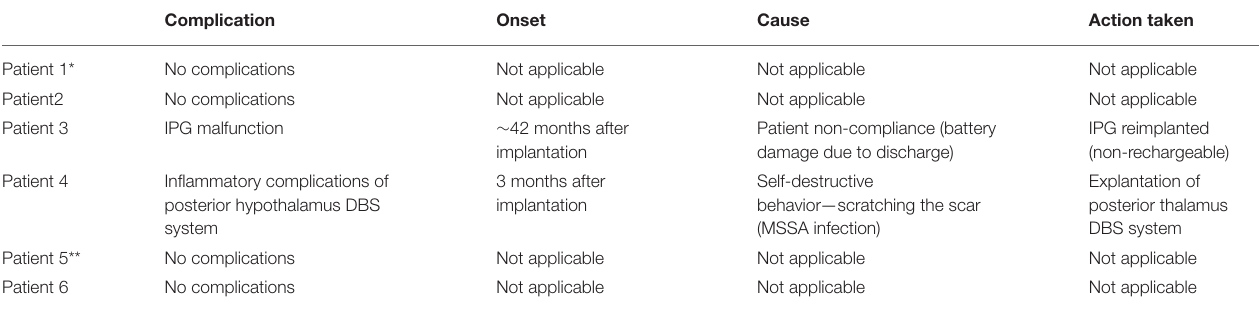
TABLE 4 | Observed complications in patients receiving